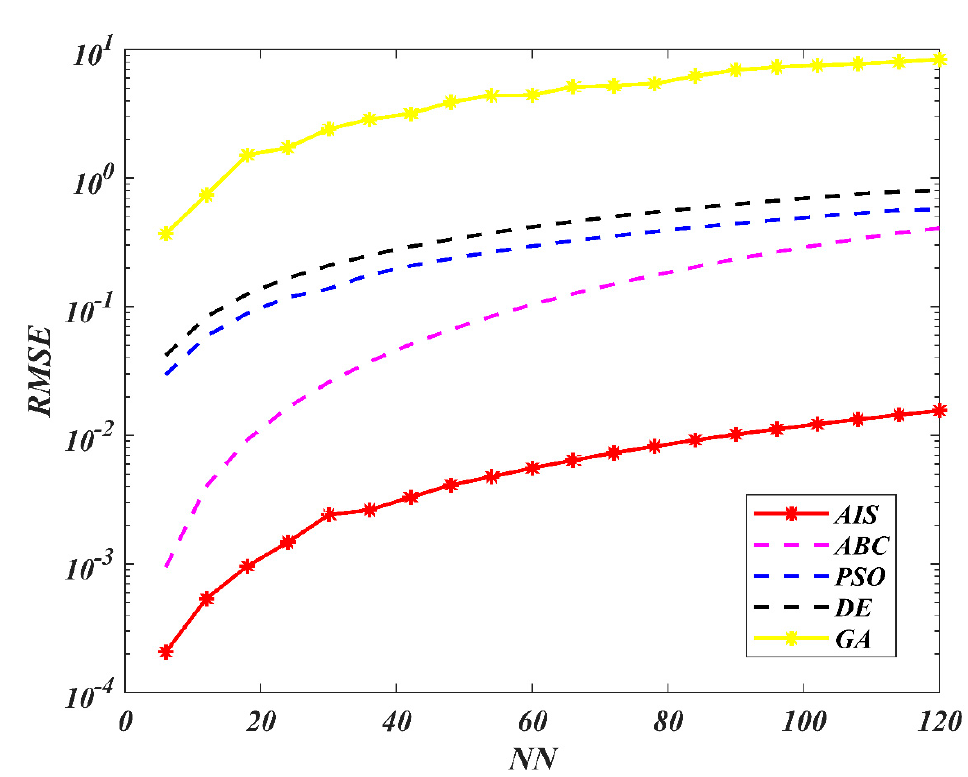
Figure 16. RMSE Evaluation for Car Evaluation.